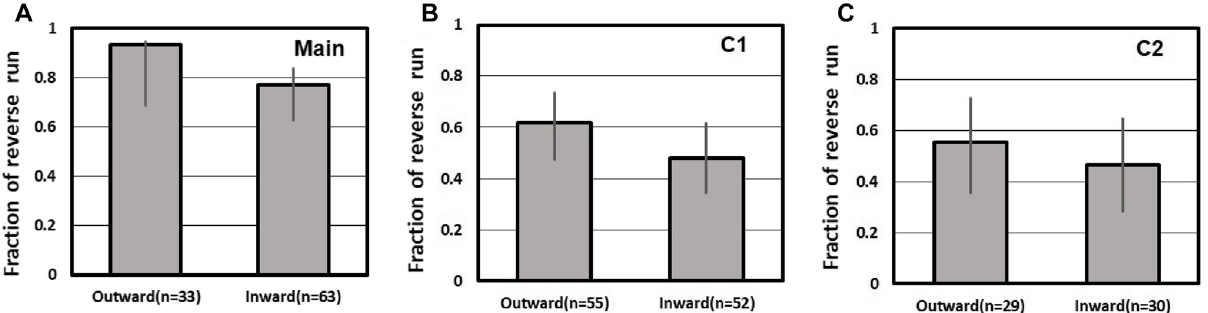
Figure 3. Fraction of the reverse run (goal) against the normal run (goal). ( A ) Main experiment. ( B ) Comparison experiment 1. ( C ) Comparison experiment 2. The error bars indicate the confidence intervals. The term n indicates the number of trials.